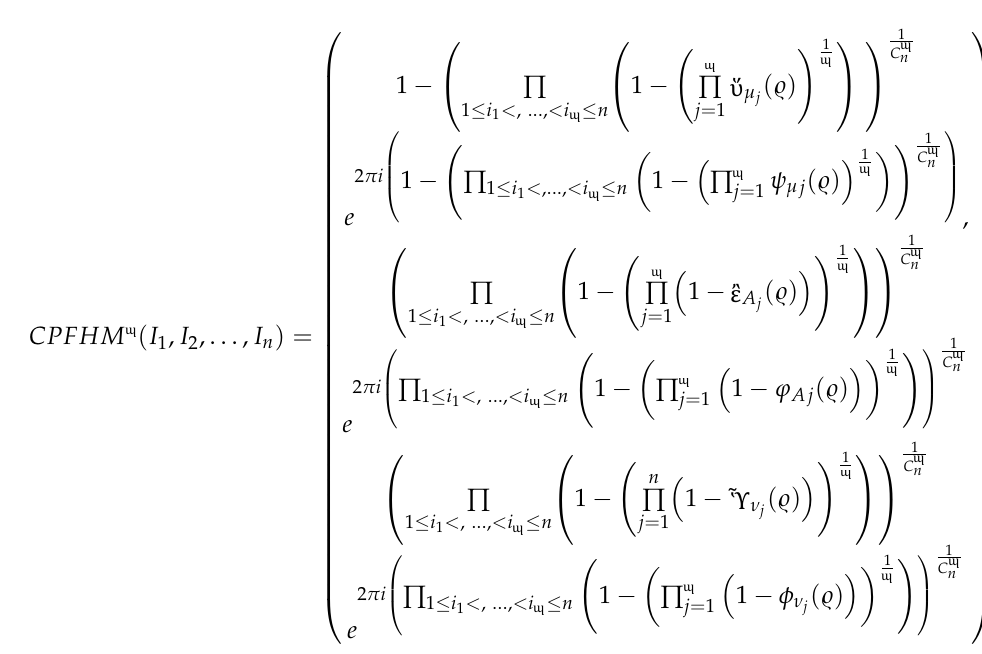
Table 1. Symbols and their meanings.